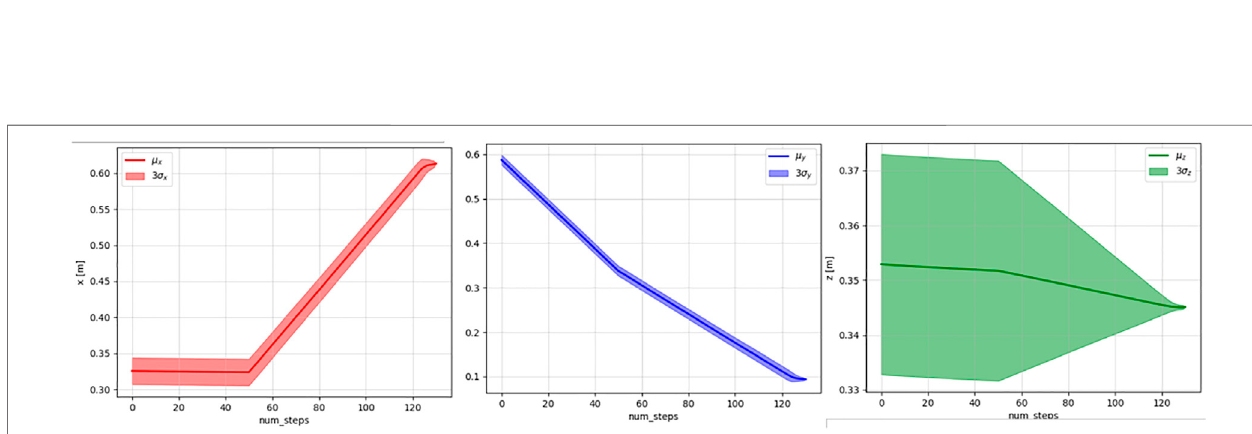
Frontiers in Robotics and AI |